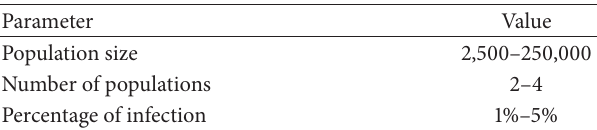
Table 2: Variable